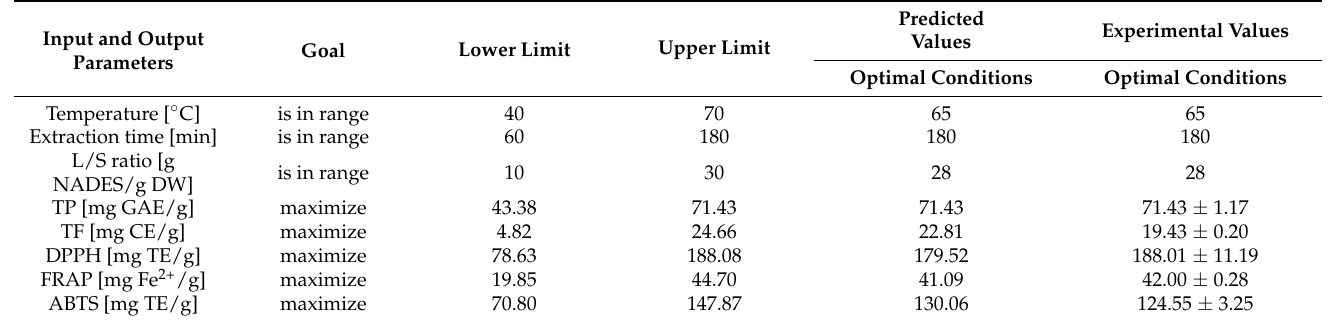
Table 4. Experimental validation of RSM optimization for NADES extraction of polyphenols and antioxidants from wild thyme.